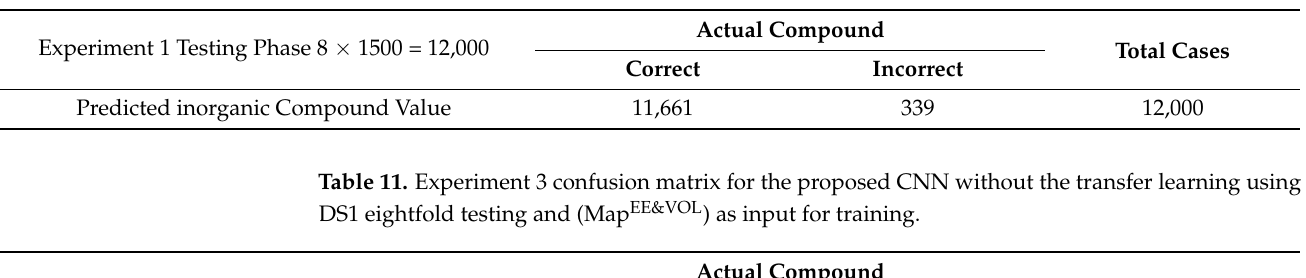
Table 10. Experiment 2 confusion matrix for the proposed CNN with the transfer learning using DS1 eightfold testing and (Map VOL ) as input for training.